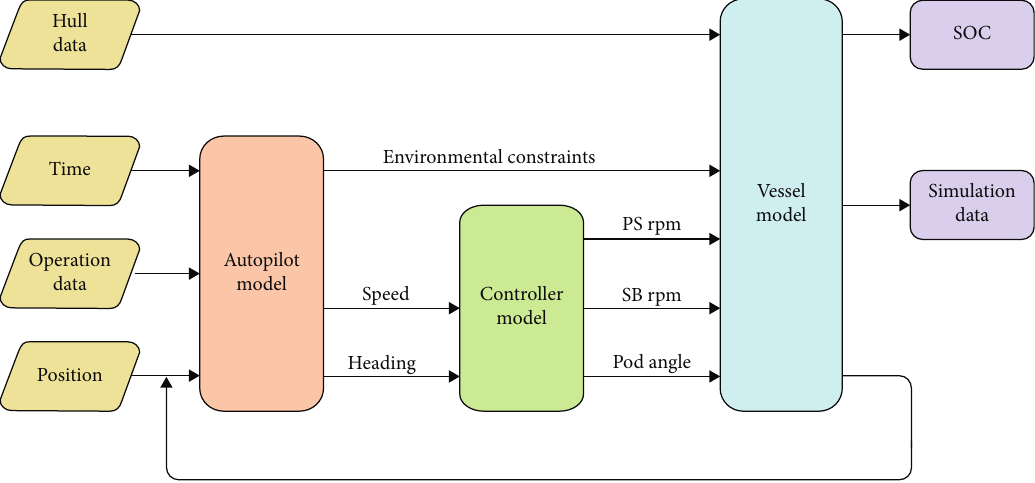
Figure 8: Global simulation model diagram.